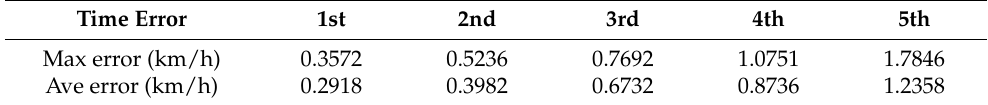
Table 1. Prediction error with pattern recognition.